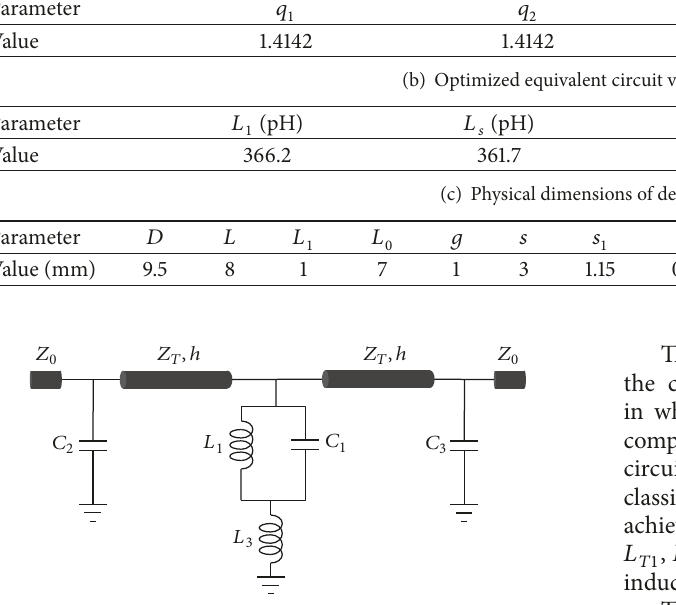
(b) Optimized equivalent circuit values (Figure 2)